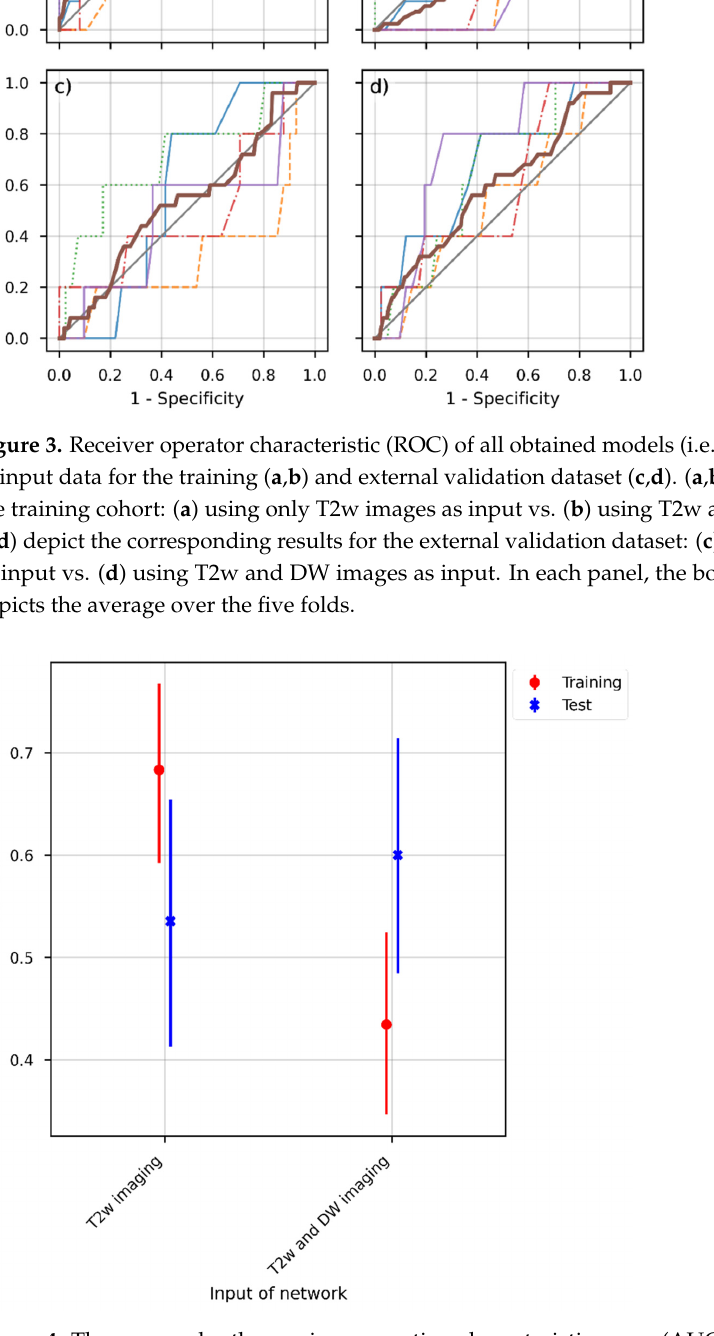
Figure 4. The area under the receiver operating characteristic curve (AUC) was calculated for the different receiver operating characteristic curves depicted in Figure 3. The AUCs are shown for the training (colored red) and test cohorts (colored blue). For the training cohort, classification with only T2w images as inputs performed significantly better than with T2w and DW images. To review model performance, we overlaid the different input images with the segmentation mask originally annotated on the high-resolution T2w images (Figure 5). As described above, the morphological images and the DW images were at times misaligned, so that the transformed segmentations incompletely or incorrectly labeled the tumor region on the DW images. In these cases of misalignment, the performance of the algorithm dropped considerably as illustrated by Figure 5.